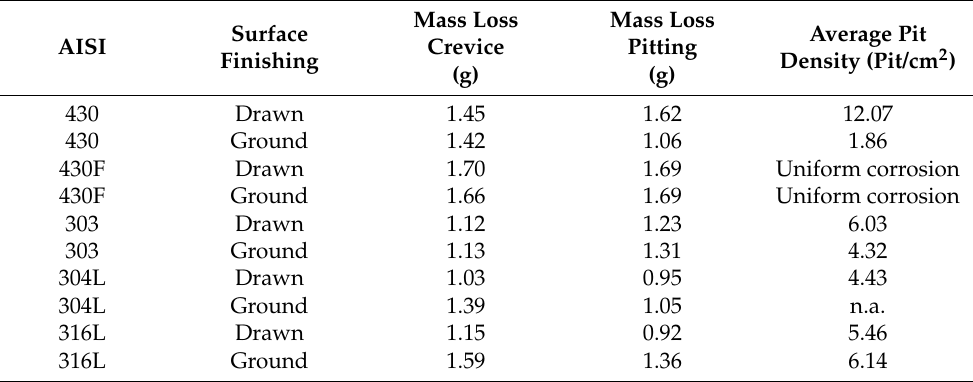
Table 6. Results of the sample analysis performed at the end of the FeCl 3 immersion test (n.a. = data not available).